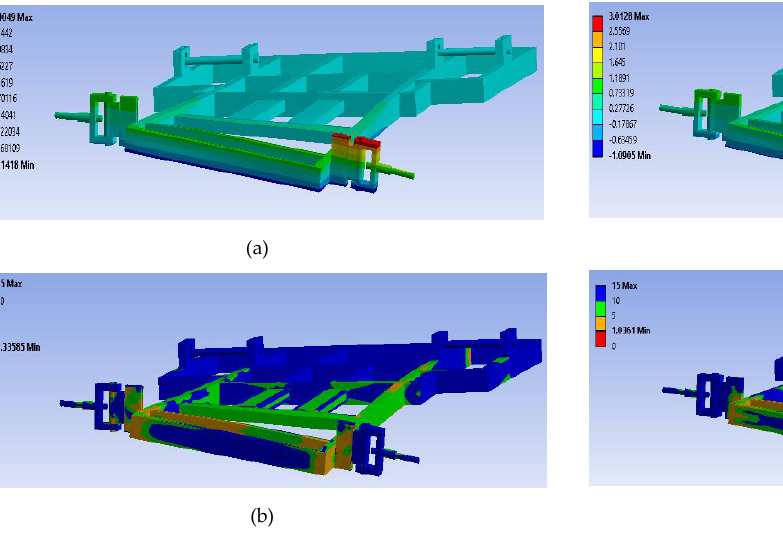
Figure 14: Deformation (a) and safety factor (b) of the third variation chassis simulation